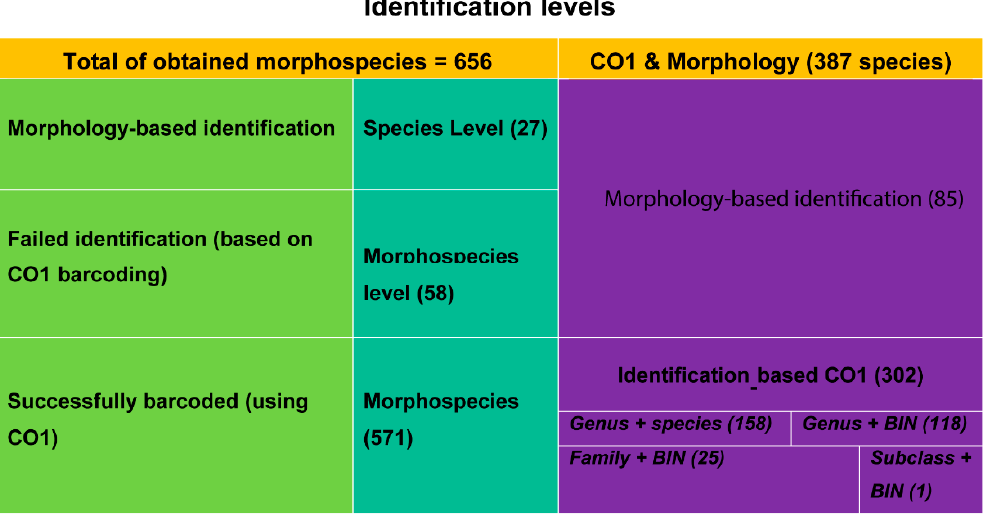
Figure 3. Identification levels. The numbers in brackets correspond to the number of species for each category .